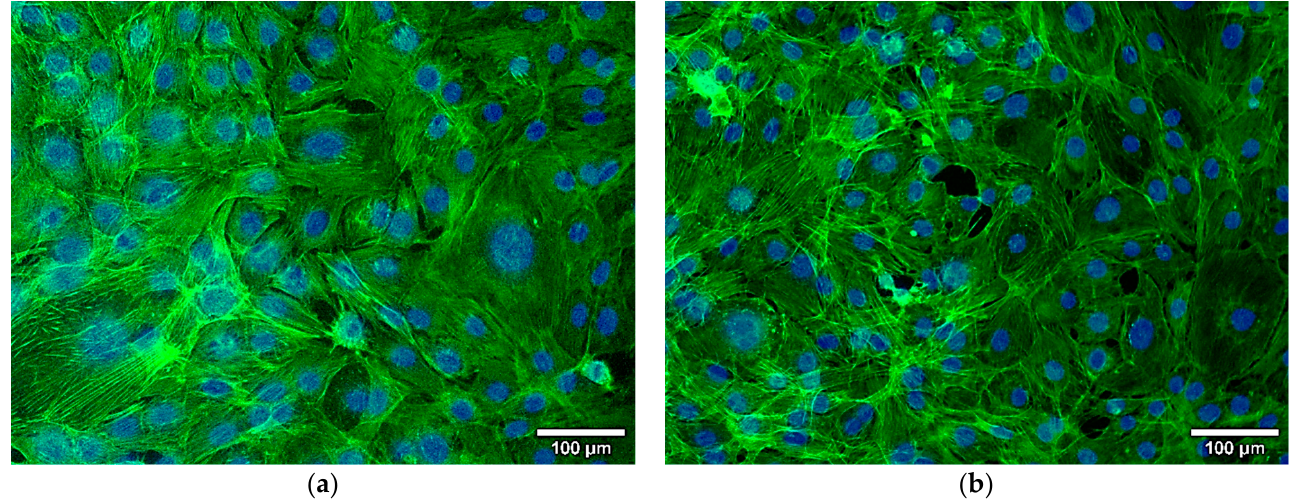
Figure 6. Fluorescence images of actin filaments of MC3T3-E1 osteoblasts cultured at 24 h on the uncoated control ( a ) and on the composite HA/MgP/BMP4 coatings ( b ).